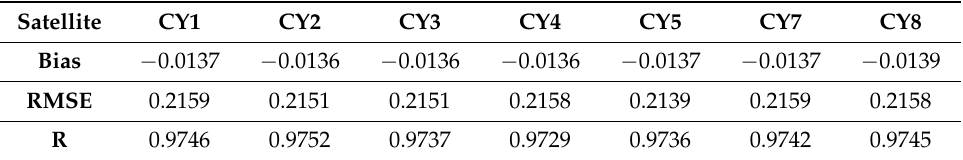
Table 1. The CYGNSS SWH estimates and ECMWF model matching results (m).